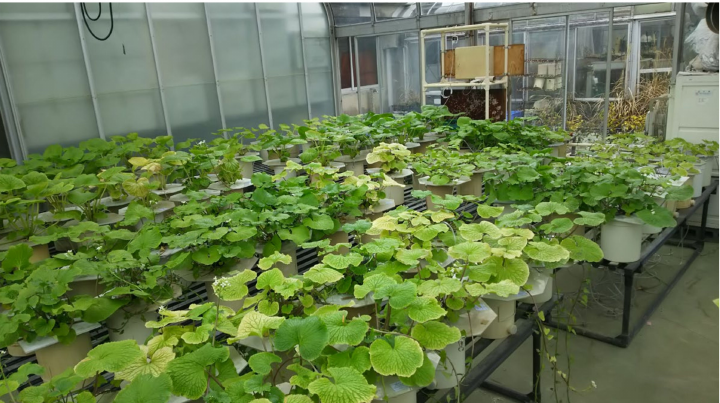
Figure 1. Hydroponic wasabi. Colours of some leaves changed due to stresses caused by pH conditions or S